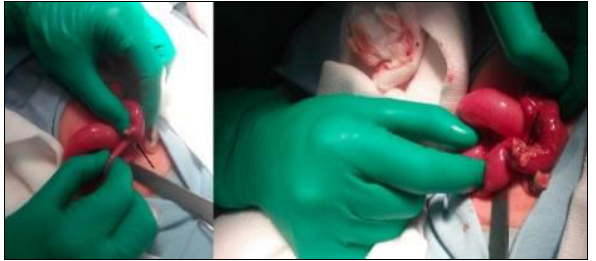
Figure 1: A: Intraoperative view showing the ileo-ileal intussu- sception (arrow). B: Intraoperative view, after reduction, show- ing the perforated Meckel’s diverticulum